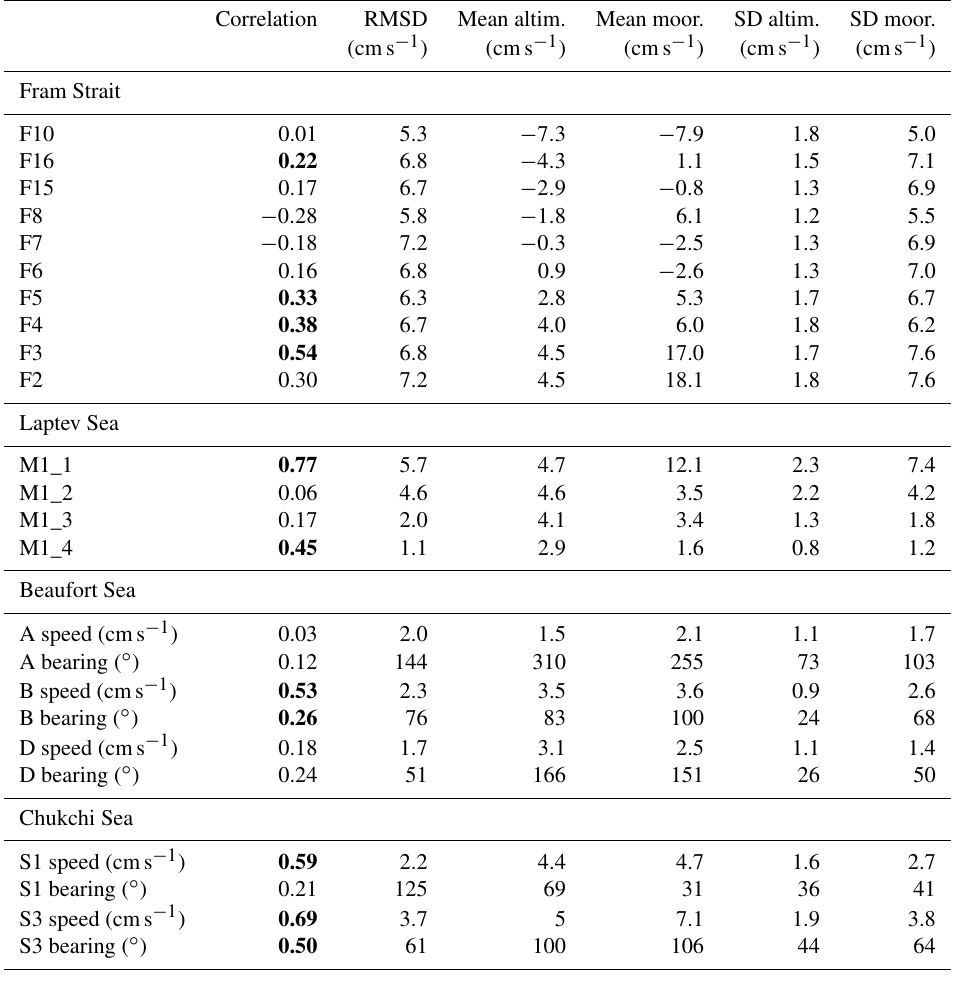
Table 4. Comparison of velocity from altimetry and mooring data. Moorings from the two mooring lines are listed, from top to bottom, respectively, as westernmost to easternmost in the Fram Strait and southernmost to northernmost in the Laptev Sea continental slope. At these two arrays, the component normal to the array is compared (northward and eastward, respectively). In the Beaufort Sea, current speed and bearing are compared. The first two columns display Pearson’s correlation coefficient and the RMSD; correlations with p value < 0 . 05 are highlighted in bold ( p values were computed using the effective number of degrees of freedom, Emery and Thomson, 2001). The next four columns show the mean and standard deviation of the altimetry-derived and mooring